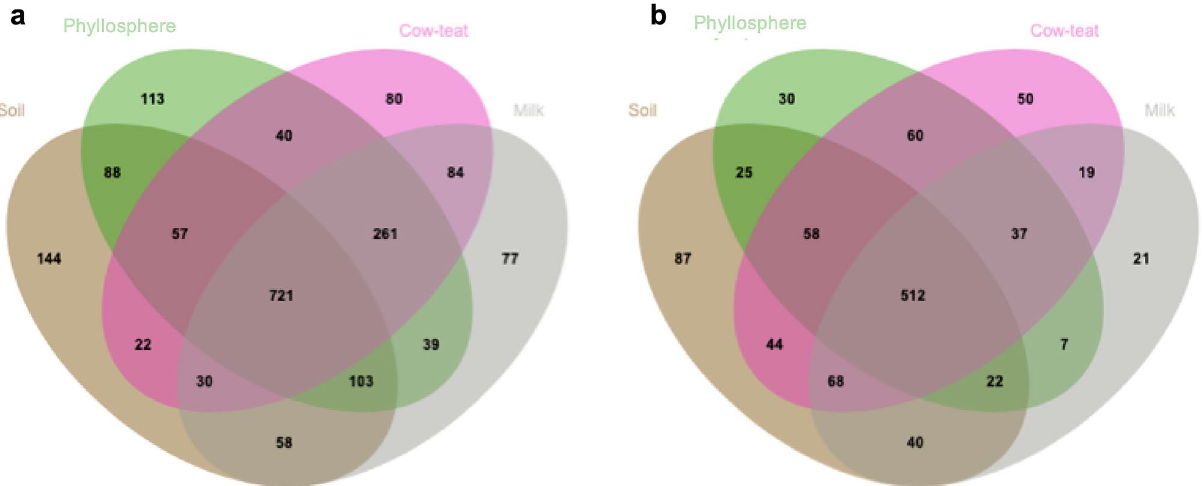
Figure 2. Venn diagrams of bacterial-archaeal ( a ) and fungal communities ( b ) over the 44 farms. Each number represents a number of genera shared by two, three or four compartments when their respective areas overlap; or specific to a compartment in non-overlapping